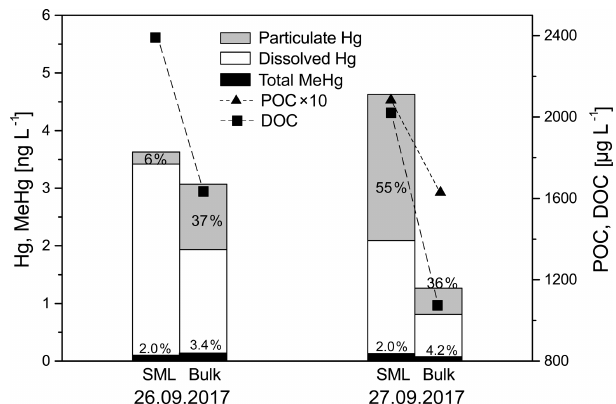
Figure 17. Concentrations of Hg, MeHg, DOC and POC in the sea surface microlayer (SML) and bulk water sampled on 26 and 27 September